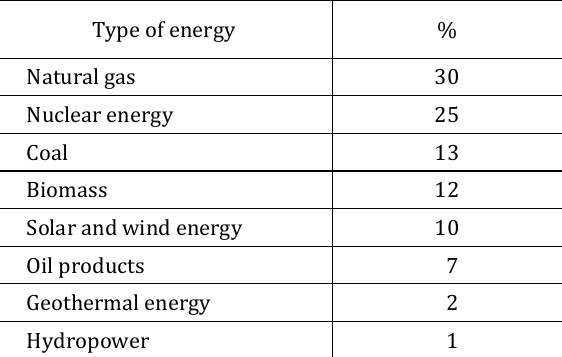
Table 1. Estimated structure of energy supply in Ukraine in 2035 (Source: formed by the authors in accordance with the Energy Strategy of Ukraine for the period up to 2035 “Security, energy efficiency, competitiveness”) Type of energy % Natural gas 30 Nuclear energy 25 Coal 13 Biomass 12 Solar and wind energy 10 Oil products 7 Geothermal energy 2 Hydropower